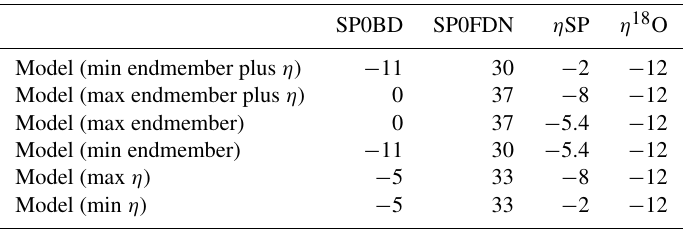
Table 4. Scenarios with different combinations of δ 18 O and site preference (SP) endmember values and η N mum and minimum estimates of % B den (minimum, maximum and average values adopted from Lewicka-Szczabak et al., 2017).